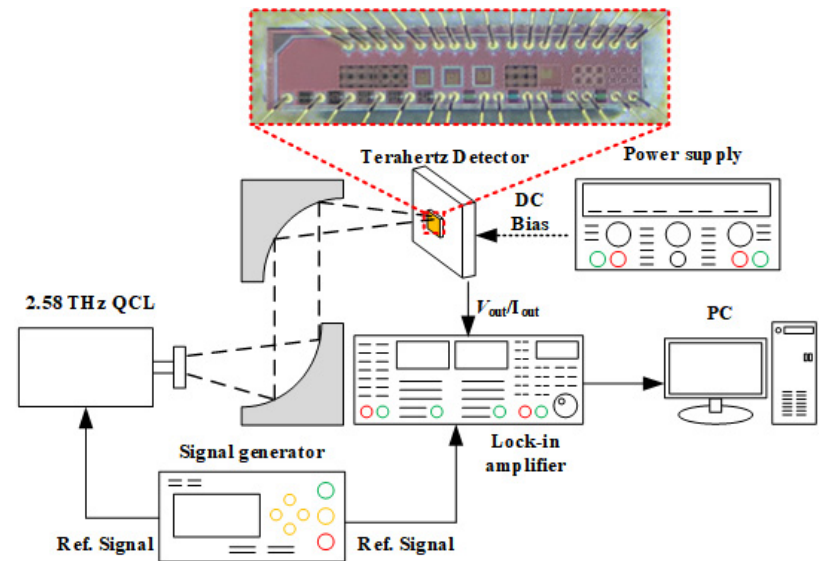
Figure 4. The THz measurement